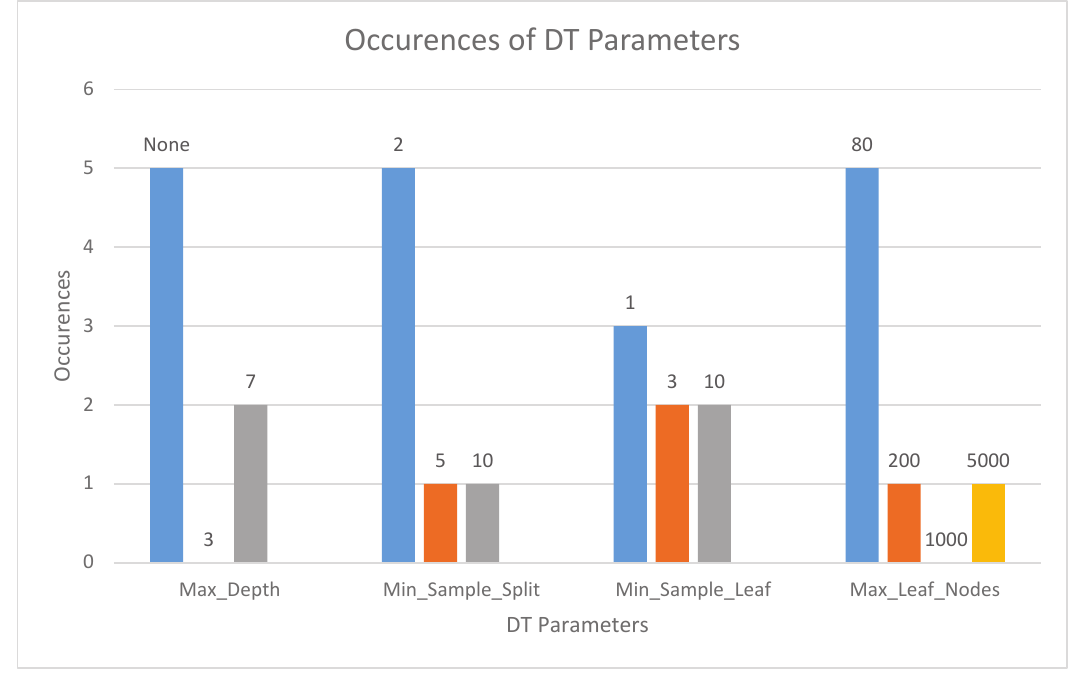
Figure 5. Number of occurrences of each DT parameter. Table 34. Training time for different values of the C parameter.